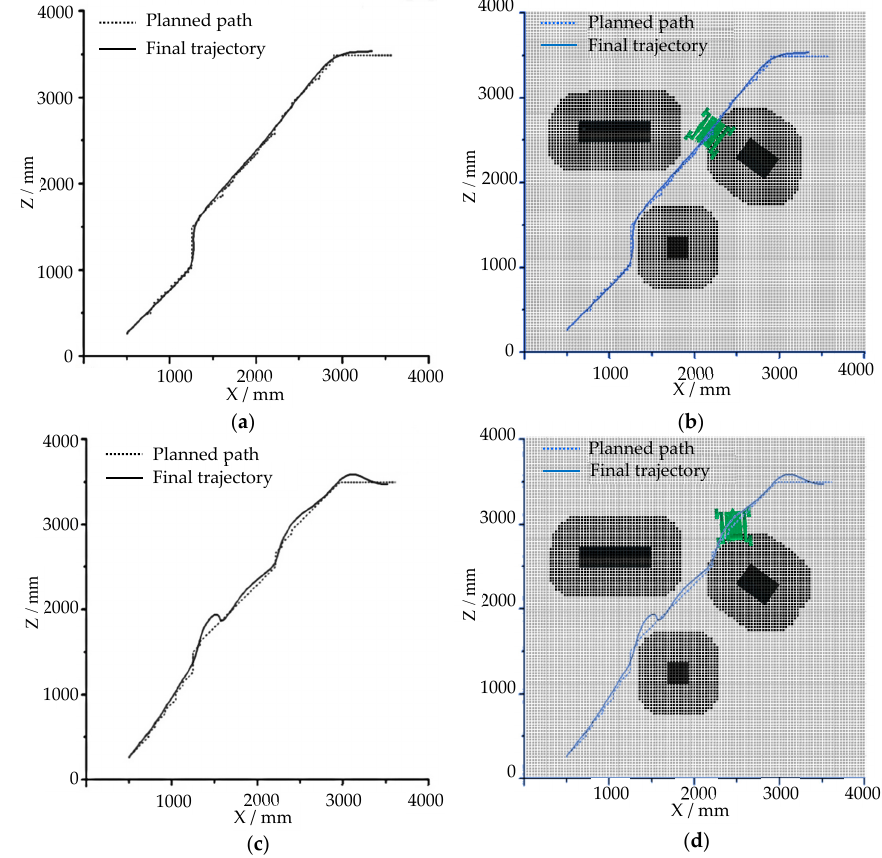
Figure 36. The curves of the planned path and final trajectory of the robot in the horizontal plane in the two motion mode: ( a ) simulation results in the first motion mode; ( b ) combination of the simulation result curves and detected terrain; ( c ) simulation results in the second motion mode; ( d ) combination of the simulation results curves and detected terrain.